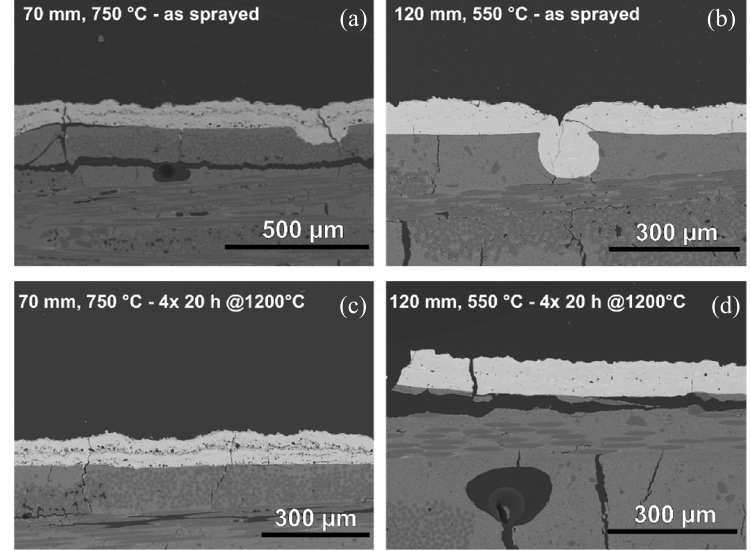
Figure 4. SEM images of the APS YAlO 3 coatings before (Coatings sprayed at a distance of 70 mm ( a ) and 120 mm ( b )) and after thermal treatment (Coatings sprayed at a distance of 70 mm ( c ) and 120 mm ( d )).